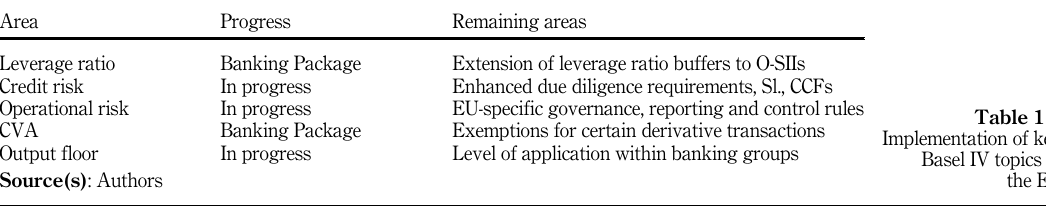
Table 11. Implementation of